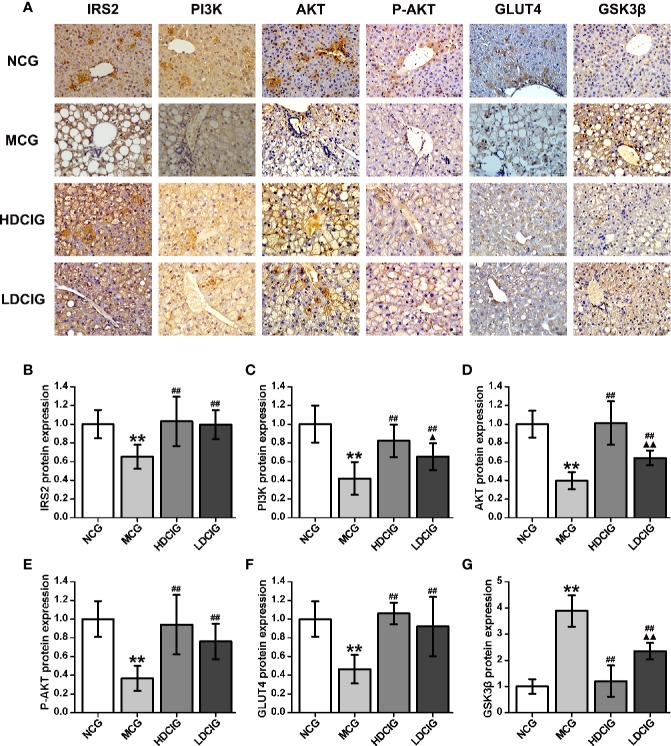
Results of immunohistochemistry for the determination of relative protein expression. (A) Representative immunohistochemical images of liver tissue regarding insulin receptor substrate 2 (IRS2), phosphatidylinositol 3-kinase (PI3K). protein kinase B (AKT), phospo-AKT (S473) (P-AKT), glucose transporters 4 (GLUT4) and glycogen synthase kinase 3β (GSK3β) (200×) are listed. (B) The result of IRS2 protein expression. (C) The result of PI3K protein expression. (D) The result of AKT protein expression. (E) The result of P-AKT protein expression. (F) The result of GLUT4 protein expression. (G) The result of GSK3β protein expression. The integrated optical density (IOD) of the immunohistochemistry-positive sites in the sample sections and the total area (Area) were determined using Image-Pro Plus 6.0. The mean optical density was calculated (MOD=IOD/Area). The results obtained for the different groups were normalized to those reported in the normal control group (NCG). All values are expressed as means ± SD, n=10. **P < 0.01 vs. (NCG) mice; ##P < 0.01 vs. model control group (MCG) mice; ▲P < 0.05, ▲▲P < 0.01 vs. high-dose D-chiro-inositol group (HDCIG) mice.